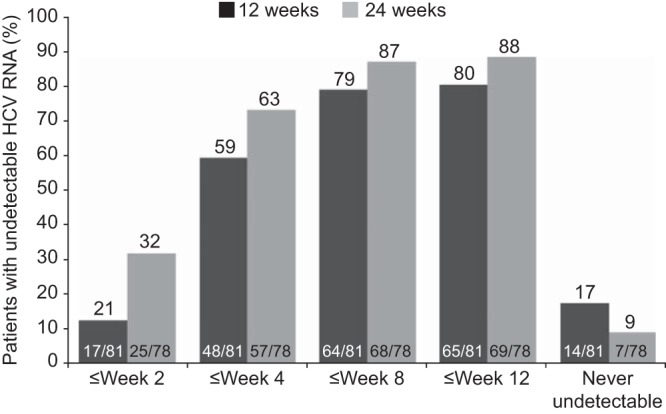
Proportion of patients with undetectable HCV RNA at different time points. Through week 12, more patients in the 24-week group than in the 12-week group achieved undetectable HCV RNA.